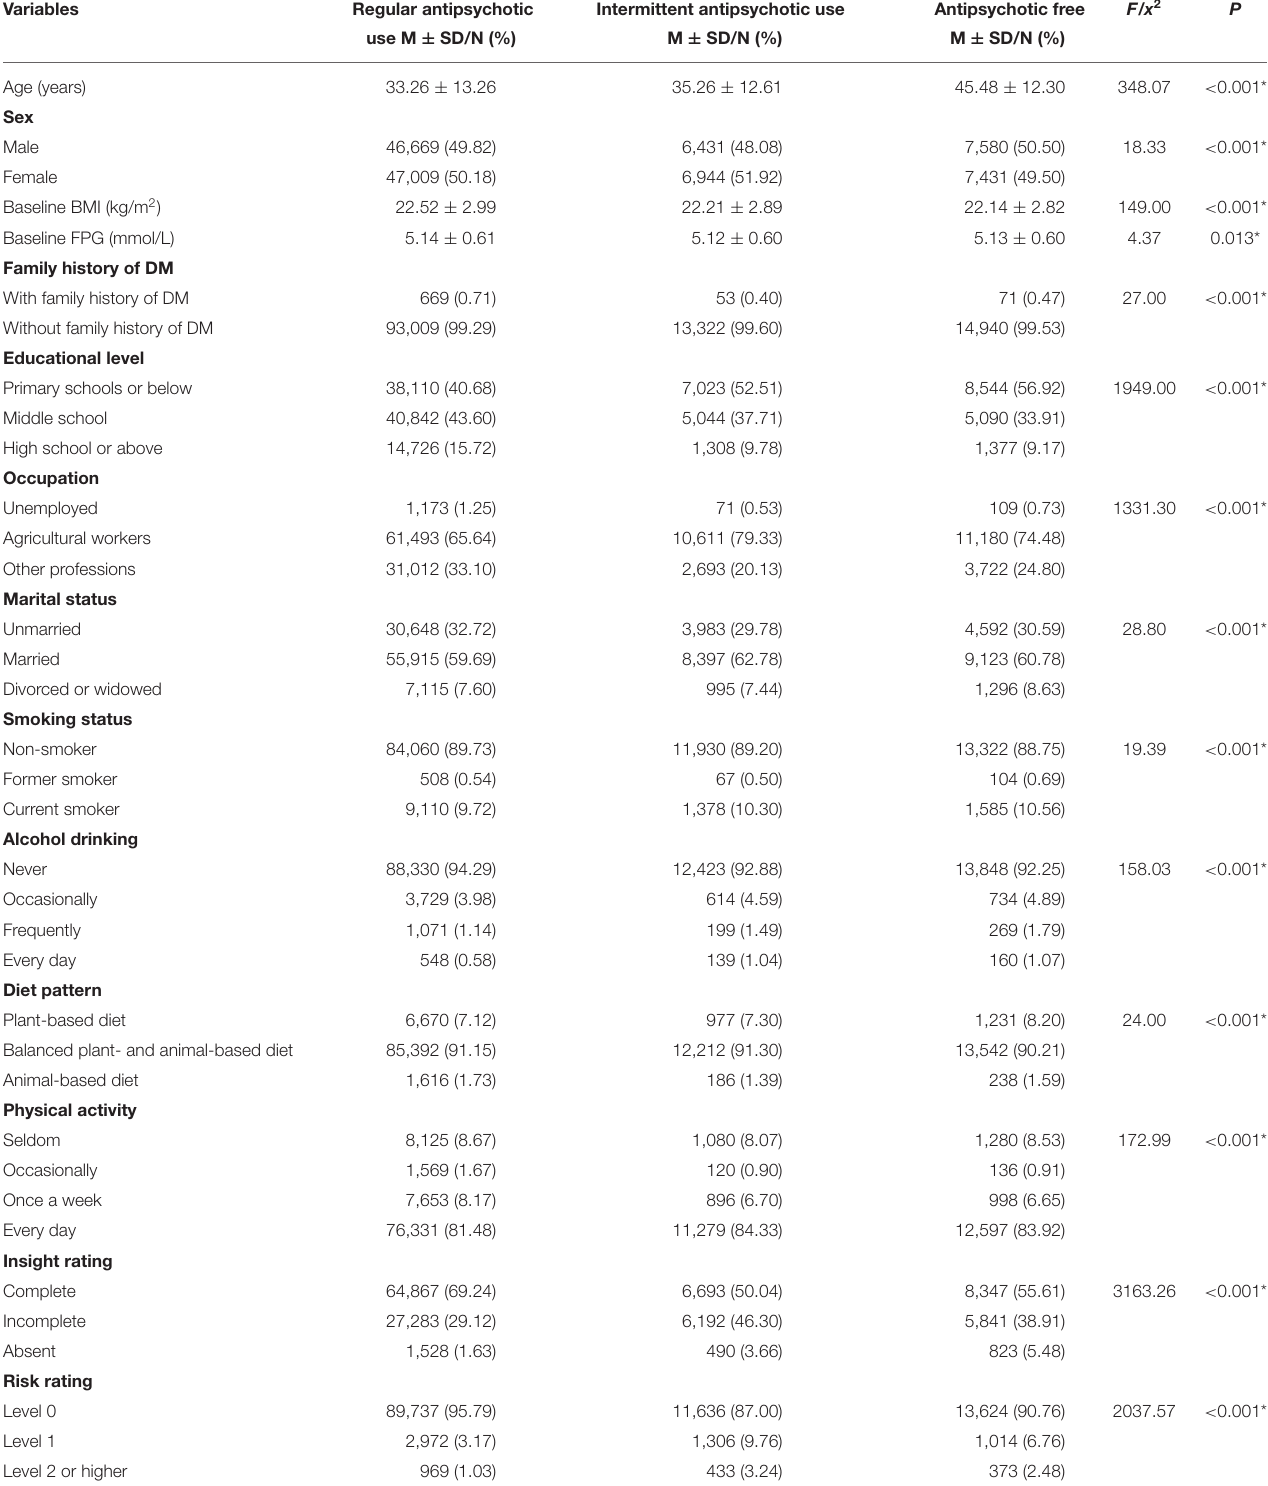
TABLE 1 | Characteristics of participants with different antipsychotic use conditions. Variables Regular antipsychotic Intermittent antipsychotic use Antipsychotic